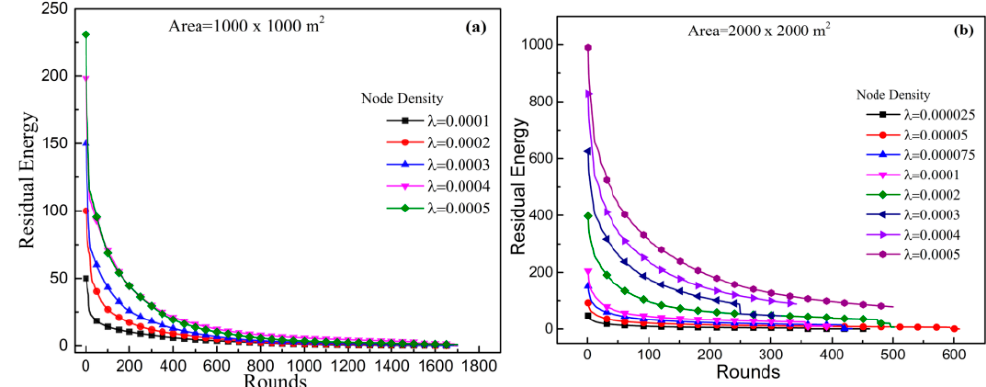
Figure 10. Residual energy per round of MGBEHA protocol for different node density in ( a ) 1000 m × 1000 m, and ( b ) 2000 m × 2000 m area.